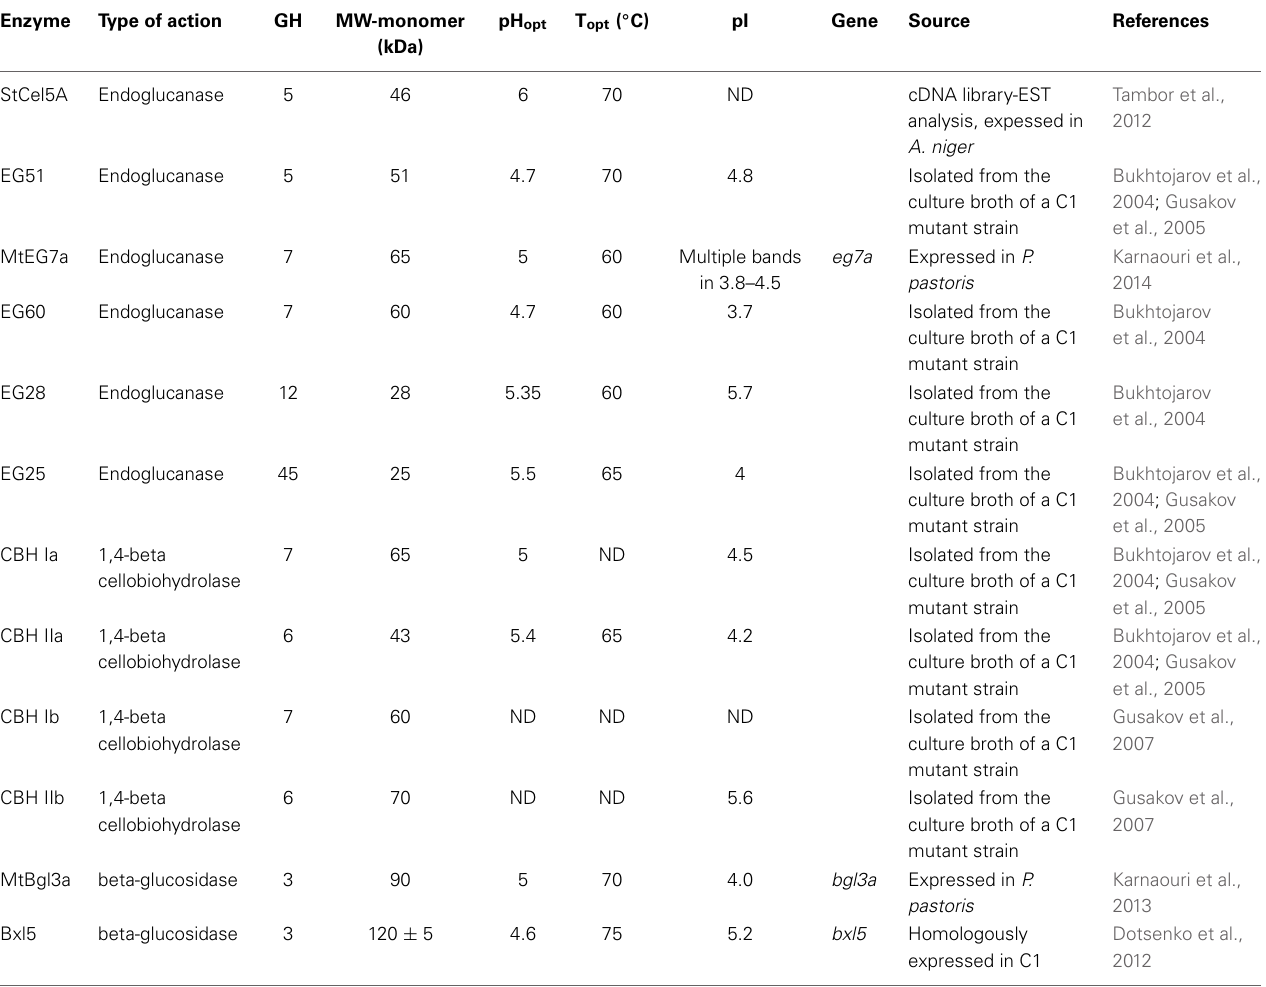
Table 3 | Description of the characterized cellulolytic enzymes either isolated from the culture broth of a M. thermophila C1 mutant strain or expressed in a heterologous